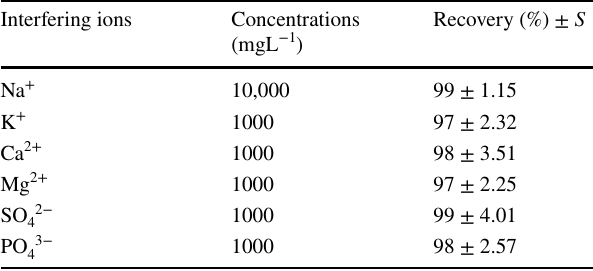
Values are average ± standard deviation for replicate samples ( n = Table 6 The effect of imprinting on the selectivity, recovery (% R ), distribution ratios ( D , mgL −1 ), selectivity coefficients ( α ) and relative selectivity coefficients ( α r ) for Fe(III)-IIP and NON-IIPr